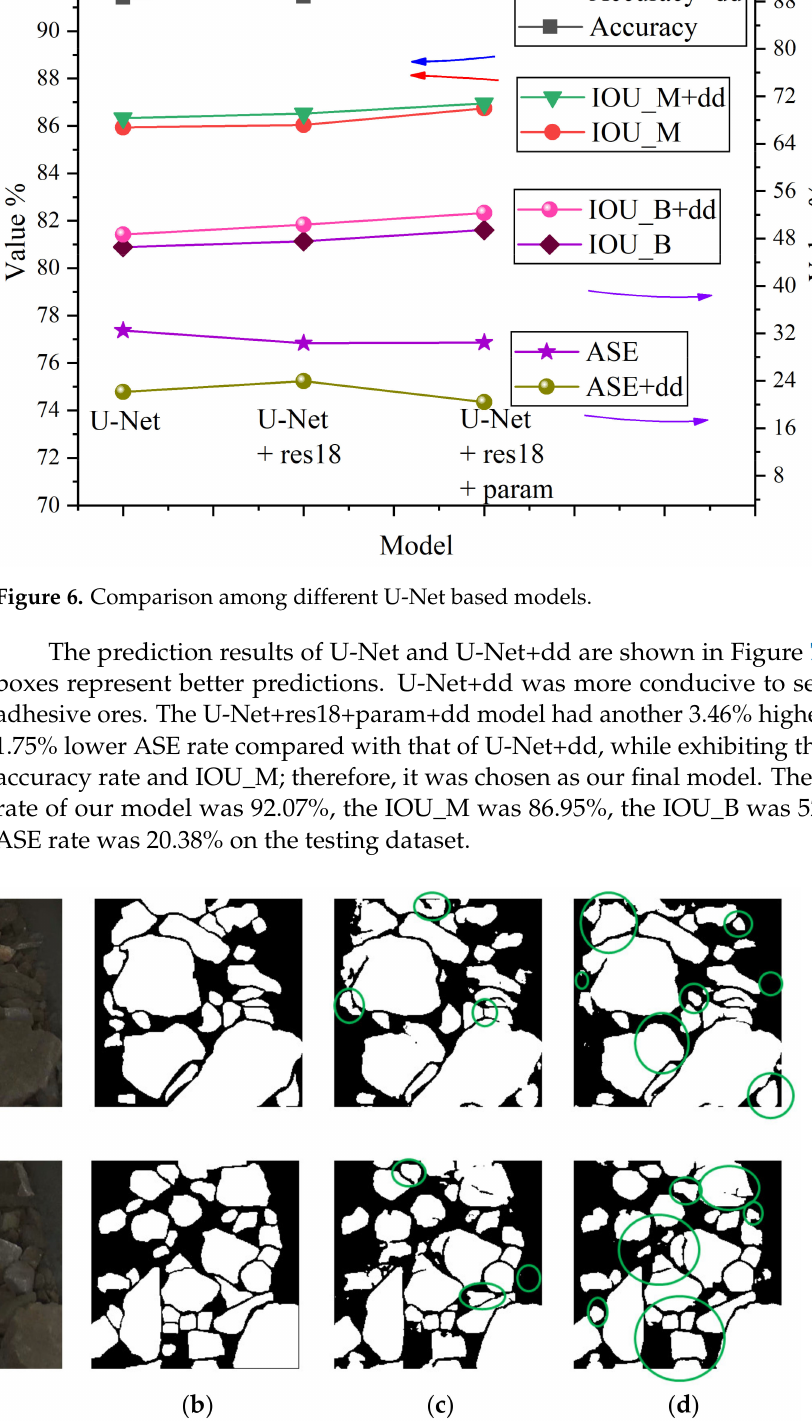
Figure 7. Predictions of U-Net and U-Net+dd: ( a ) the raw image; ( b ) the ground truth; ( c ) the U-Net result; and ( d ) the U-Net+dd